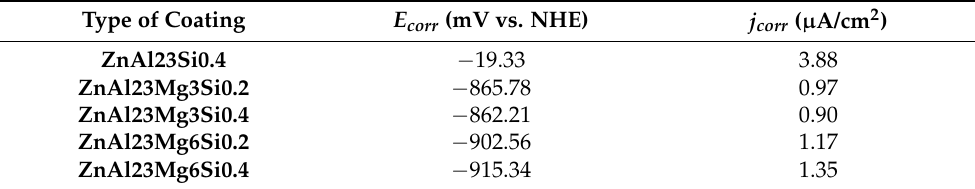
Figure 12. Curves of anodic and cathodic polarization of ZnAl23MgSi coatings and the reference ZnAl23Si0.4 coating in 3.5% NaCl solution. Table 9. Electrochemical parameters of corrosion of tested coatings in 3.5% NaCl solution.